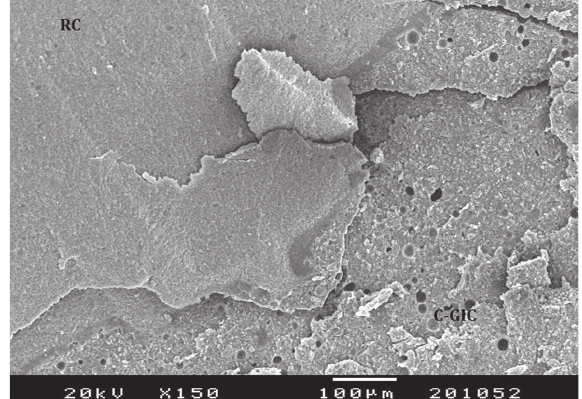
Figure 7- Mixed type fracture in the debonded area of a sample in which Adper Single Bond was used. C-GIG= conventional glass ionomer